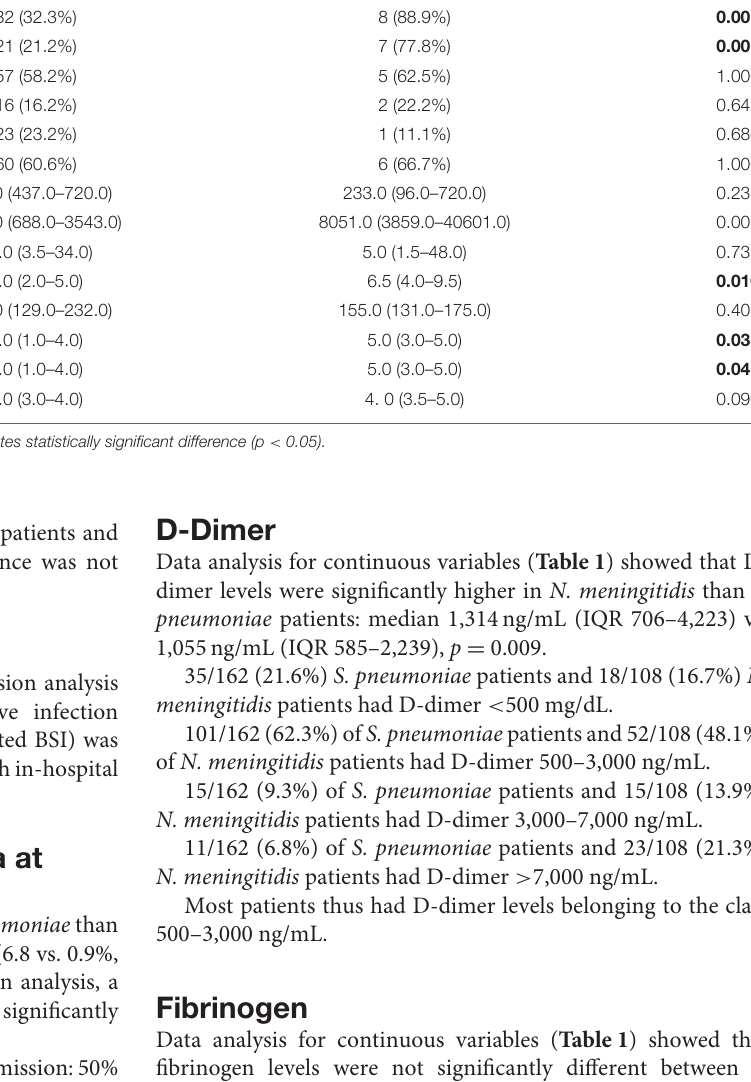
Data analysis for continuous variables ( Table 1 ) showed that fibrinogen levels were not significantly different between S.